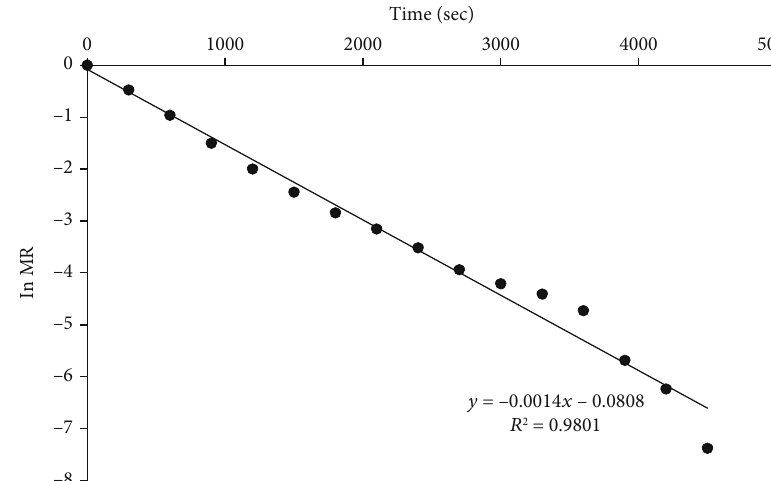
Figure 7: A plot of ln MR and time of jackfruit dried with